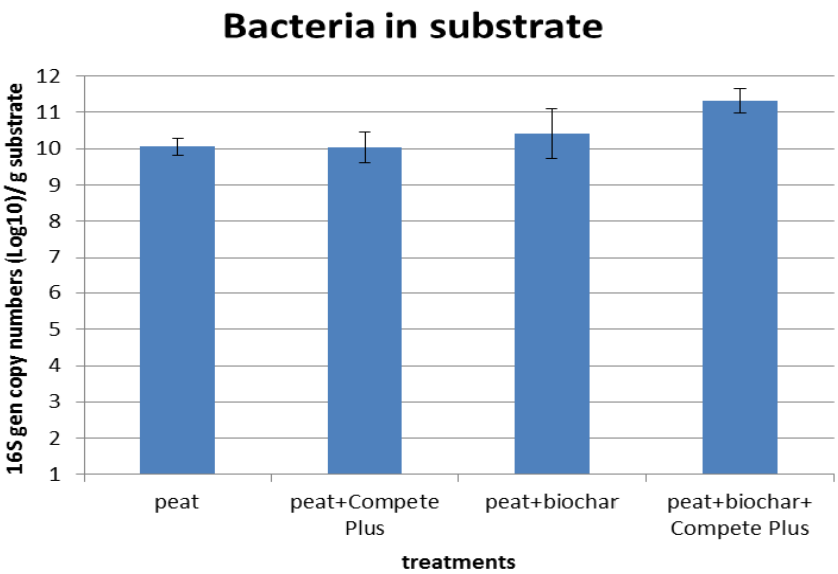
Figure 7. Total Bacteria numbers (on basis of log10 of copy numbers of 16S gene per g dry medium).